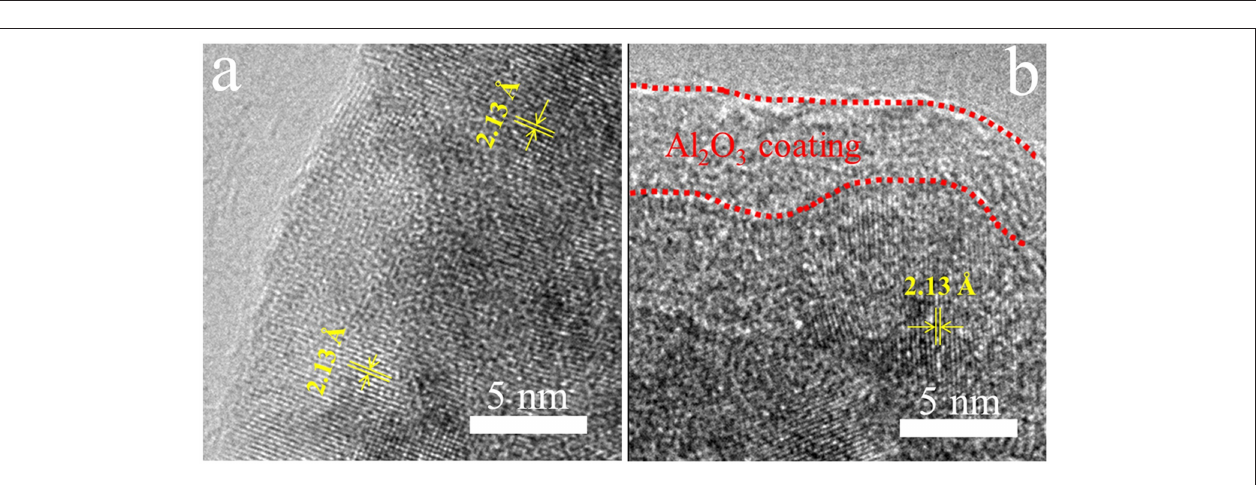
FIGURE 3 | HR-TEM images of (a) LTMO and (b) LTMO/24Al 2 O 3 . be the thick insulated Al 2 O 3 layer may inhibit the electric and ionic transportation (Jung et al., 2010). Based on above results, it can be concluded that proper thickness of Al 2 O 3 layer can greatly improve the cycling stability of LTMO electrodes,